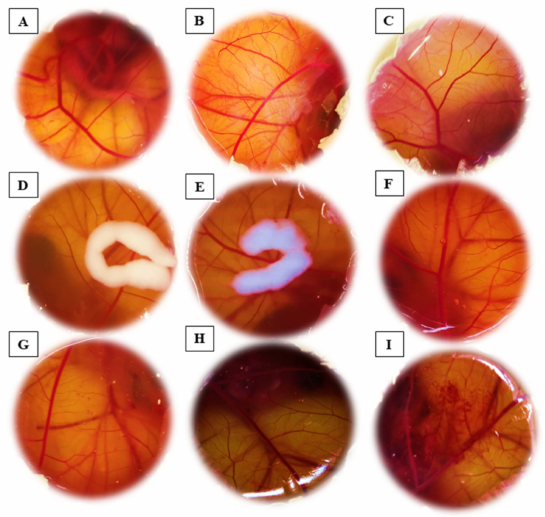
Figure 9. Representative images of the chorioallantoic membrane (CAM) test after the application of the ( A ) sesamol solution; ( B ) NC SES; ( C ) NC placebo; ( D ) Hydrogel NC SES; ( E ) Hydrogel NC placebo; ( F ) Hydrogel free SES; ( G ) Hydrogel vehicle; ( H ) negative control—NaCl 0.9%; ( I ) positive control—0.1 M